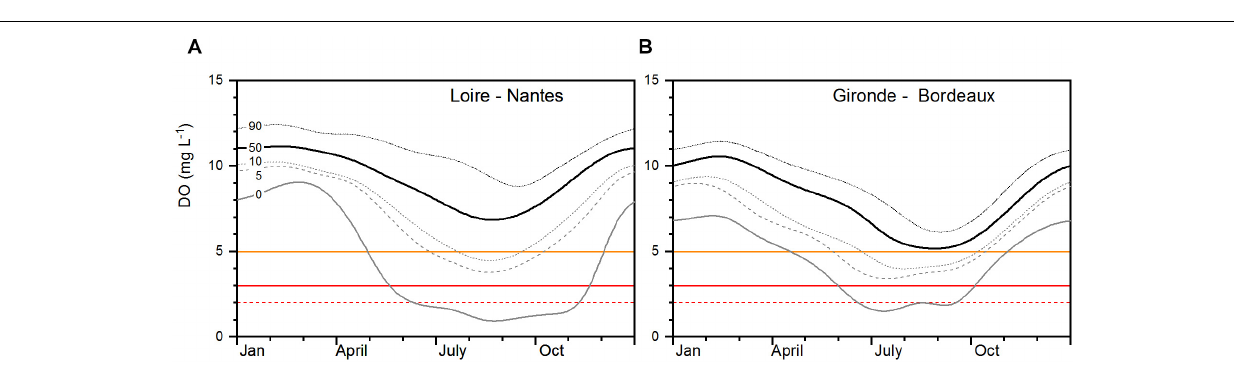
FIGURE 3 | Monthly distribution of percentiles values of DO (0, 5, 10, 50 and 90 percentiles) in the urban section of the panel (A) Loire (Nantes) and panel (B) Gironde (Bordeaux) estuaries. The horizontal lines correspond to the values of 2 (the commonly used threshold for hypoxia), 3 and 5 mg L − 1 . Values between 3 and 5 induce stress for most